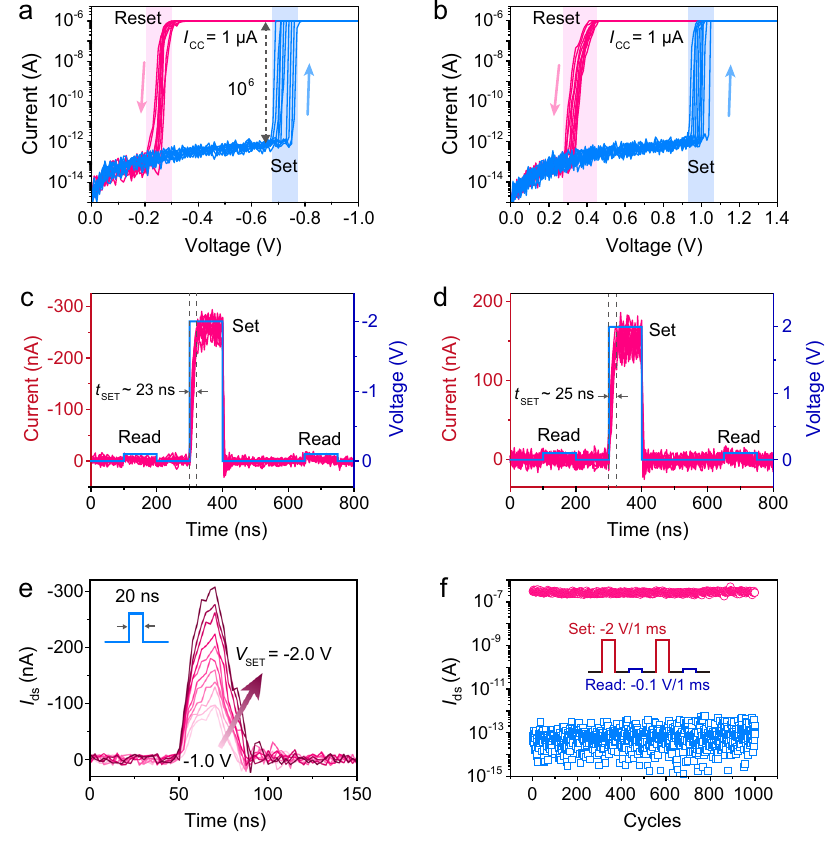
Fig. 2 | Threshold switching device with a structure of WSe 2 /GDYO/MoS 2 . I – V curvesoftheTSdeviceinnegative( a )andpositive( b )voltageregions,respectively, demonstrating a typical TSbehavior.Compliance current ( I CC ) wasset as1 μ A.The sweeping voltage was applied to the WSe 2 terminal and the MoS 2 terminal was grounded. Transient responses of the TSdevice to – 2V/100ns ( c ) and +2V/100ns ( d ) voltage pulses. The switching time measured in c and d are 23ns and 25ns, respectively. ±0.1V/100ns voltage pulses were applied for read operations before